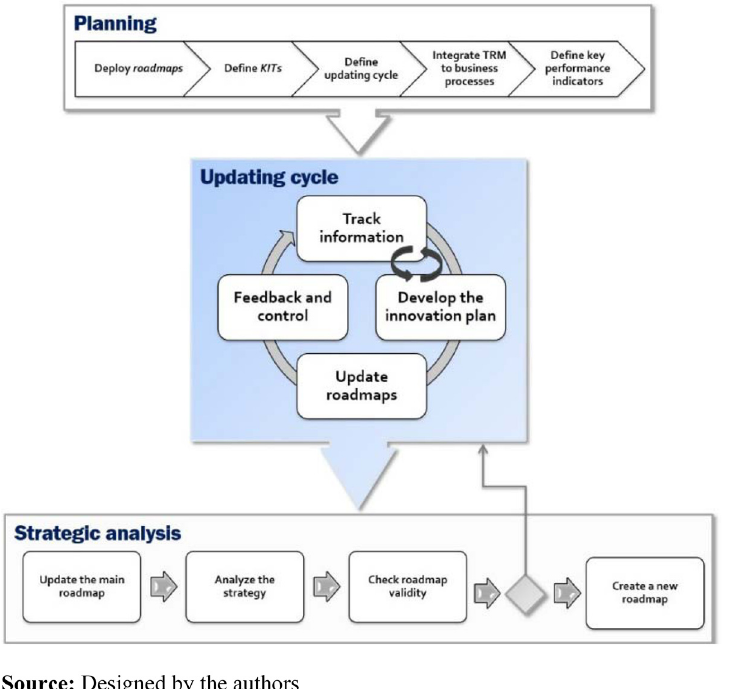
Figure 1. Framework for updating